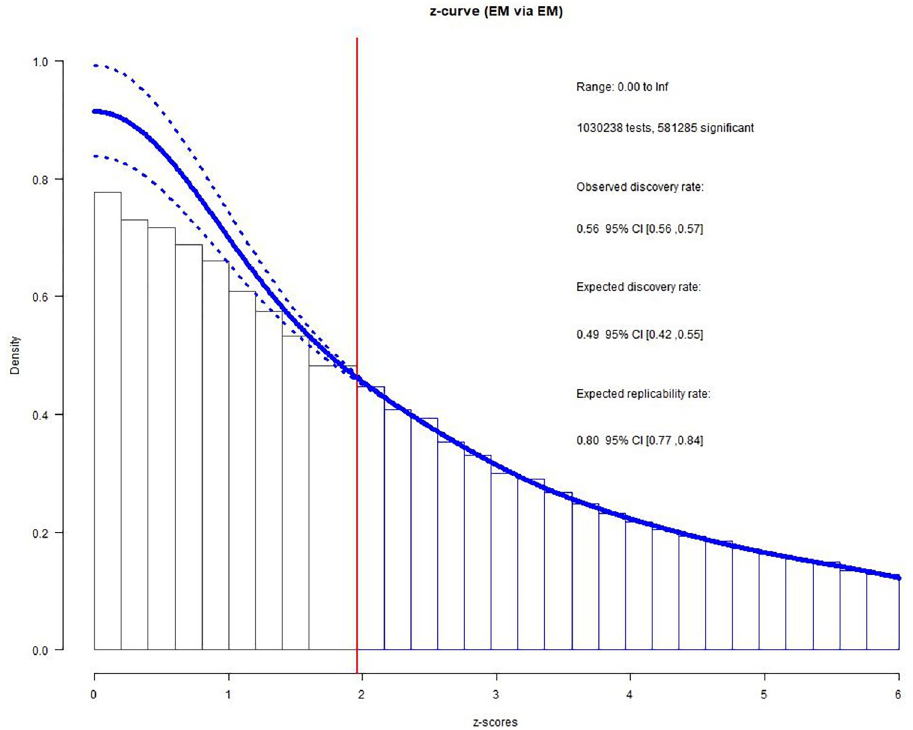
Fig 2. Z-curve results for the complete metaBUS